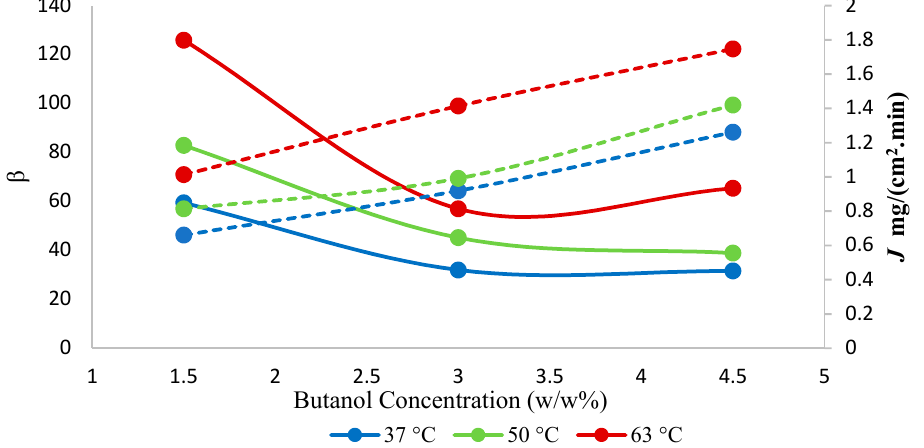
Figure 8. Effect of temperature on total flux ( J ) and separation factor ( β ) using hybrid PTMSP membrane. Solid lines represent separation factor, and dotted lines represent total flux.